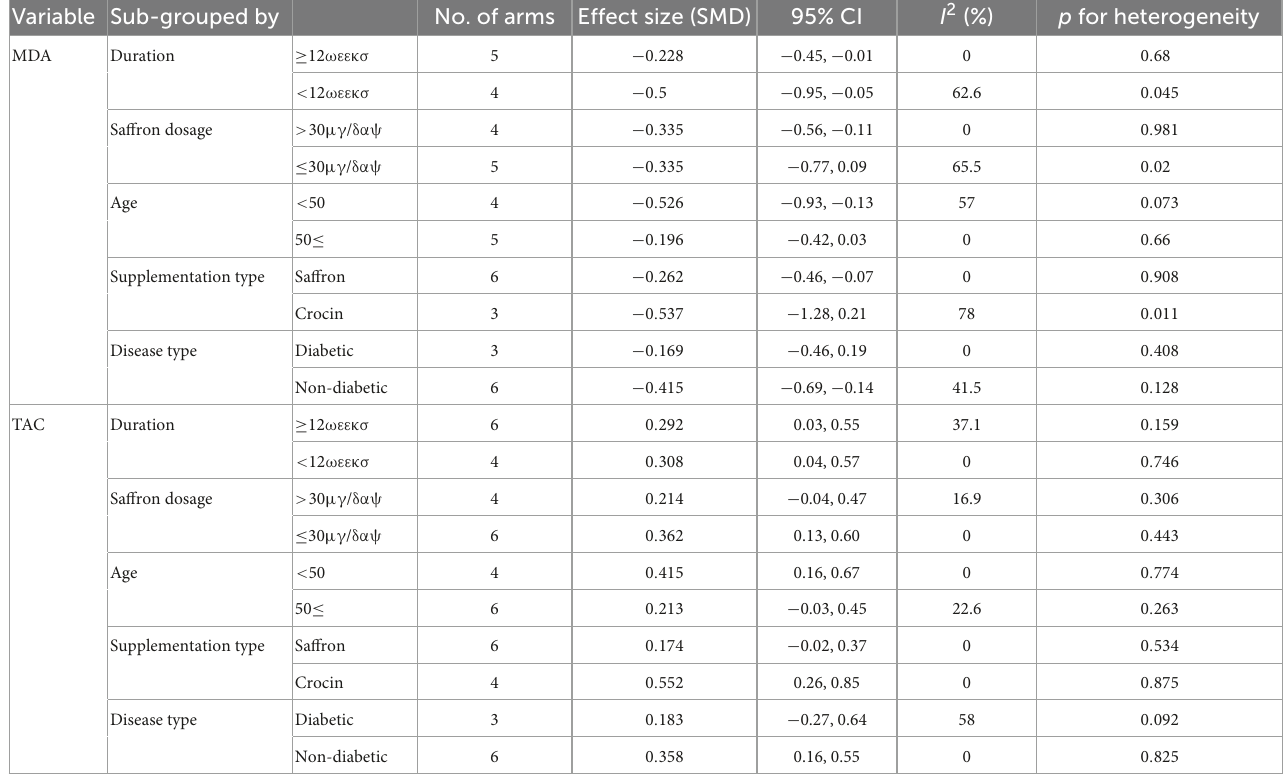
TABLE 3 Subgroup analysis assessing the effect of saffron intake on MDA and